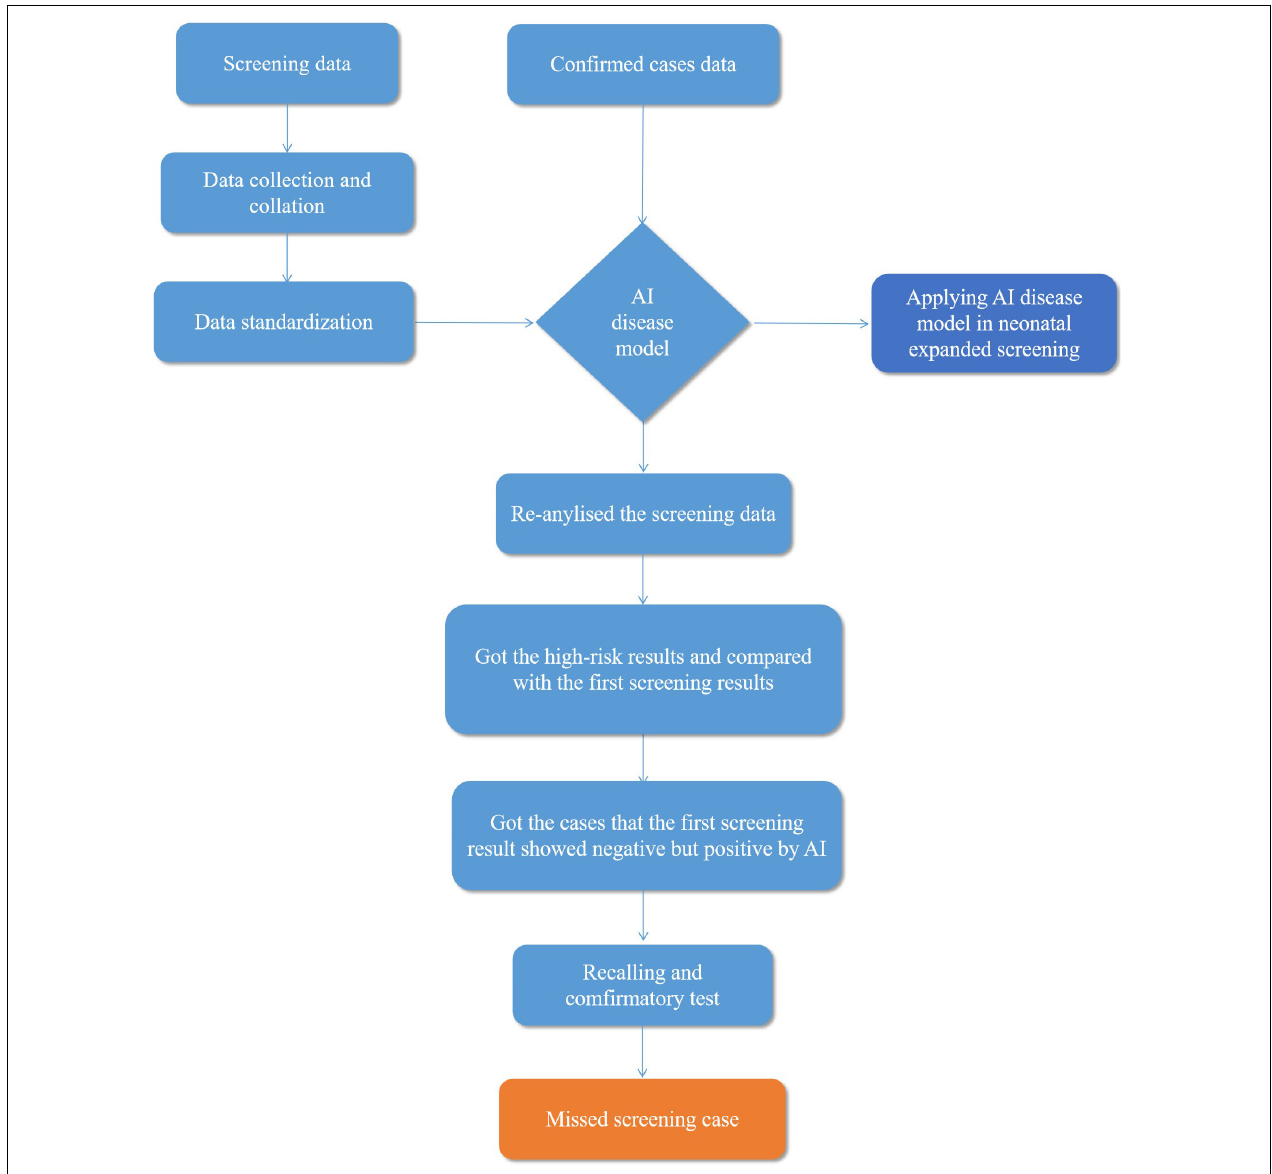
FIGURE 1 | Flow diagram explaining artificial intelligence (AI) disease model applied in neonatal screening.